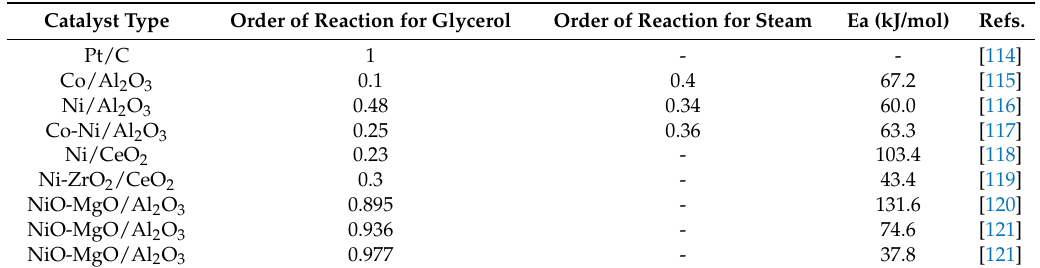
Table 1. Some catalysts for GSR reaction (adapted from Bagnato et al. [13]). Catalyst